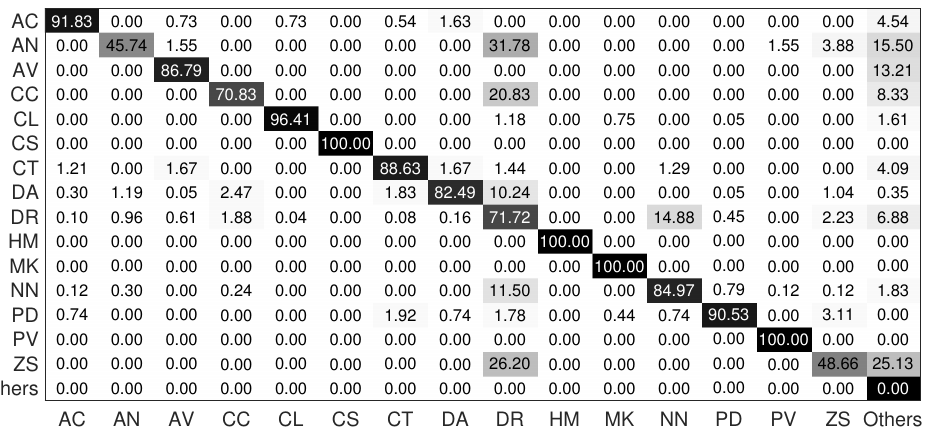
Figure 14. Confusion matrix of the hierarchical model for the LCF-15